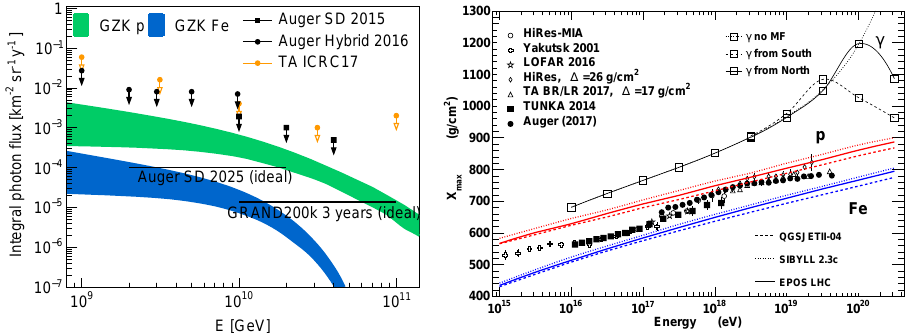
Figure 2: Left: GRAND sensitivity to UHE photons [ 16–19 ] . Right: Measurements of the average depth of shower maximum as a function of energy [ 20–26 ] as well as the results for several simulations [ 27 ]